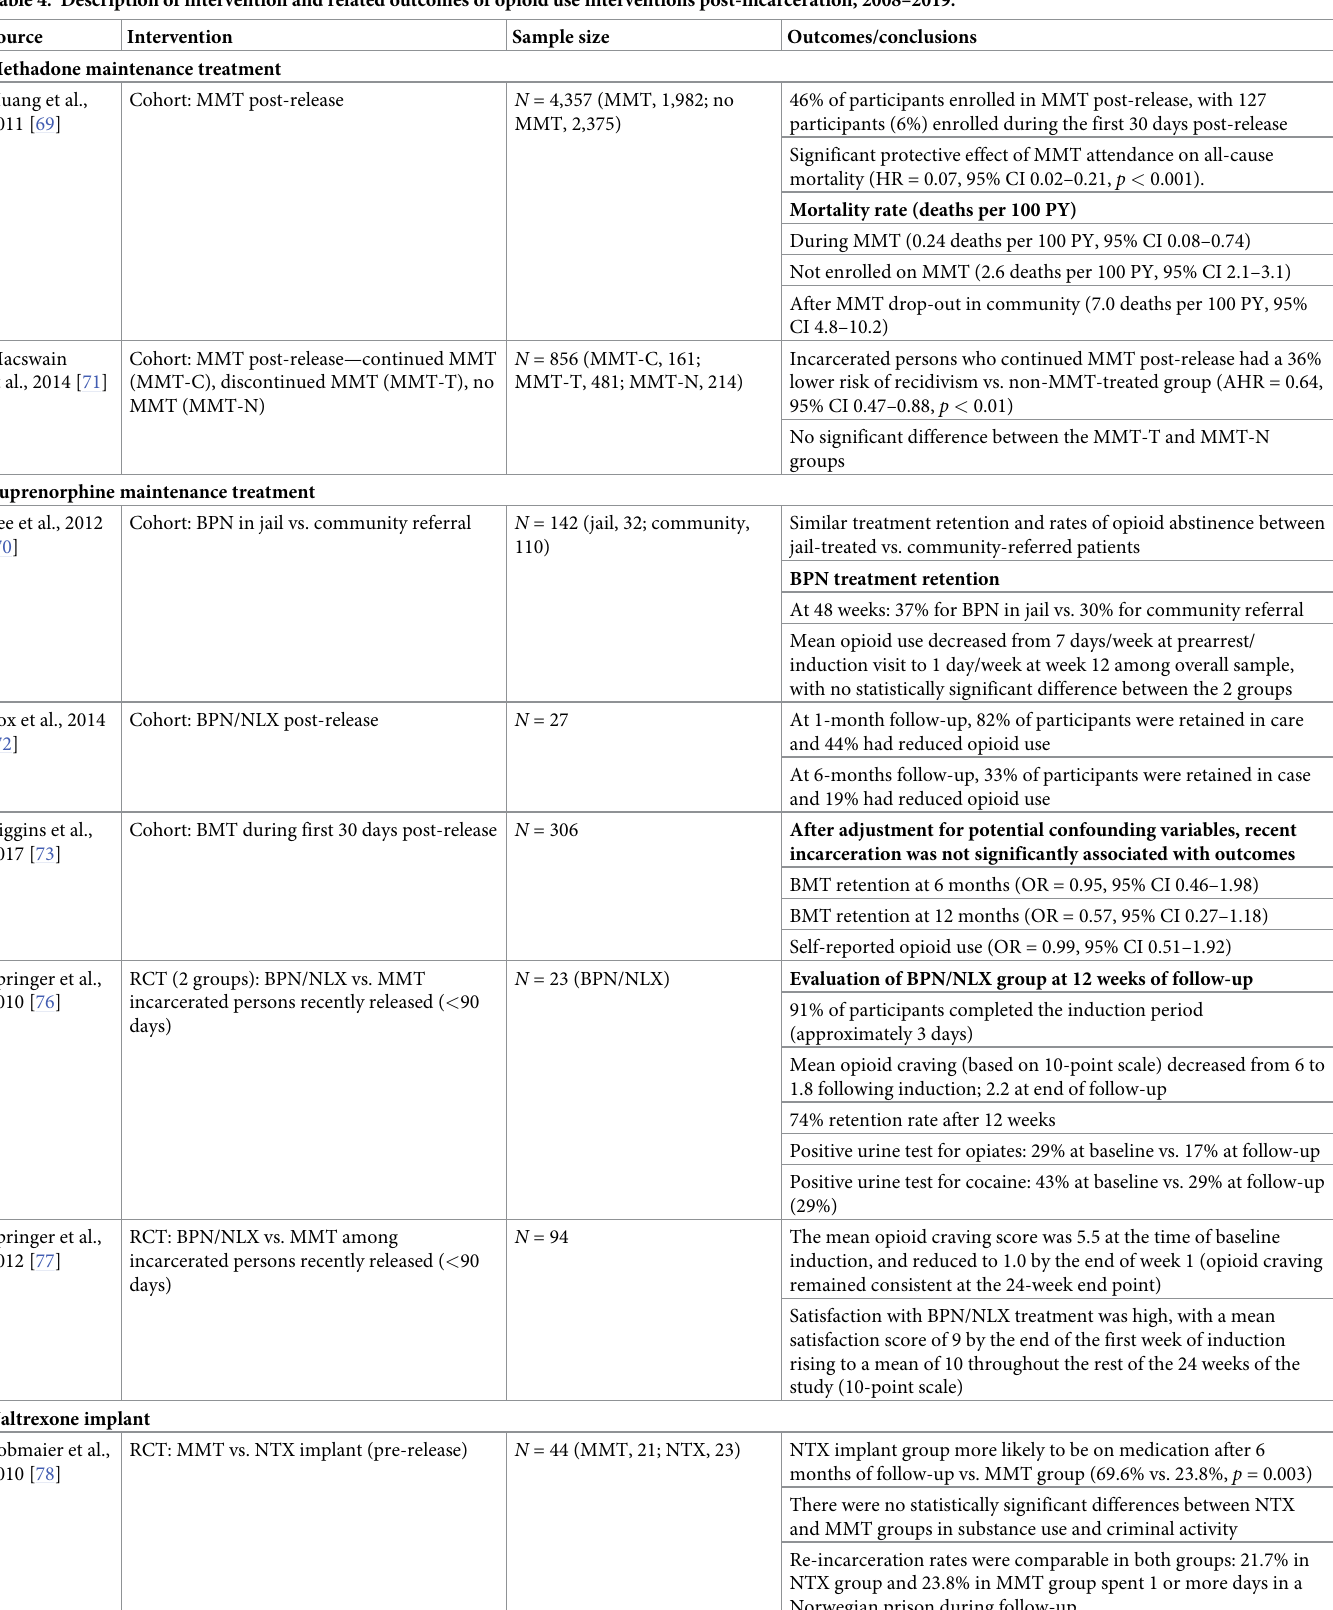
Table 4. Description of intervention and related outcomes of opioid use interventions post-incarceration,